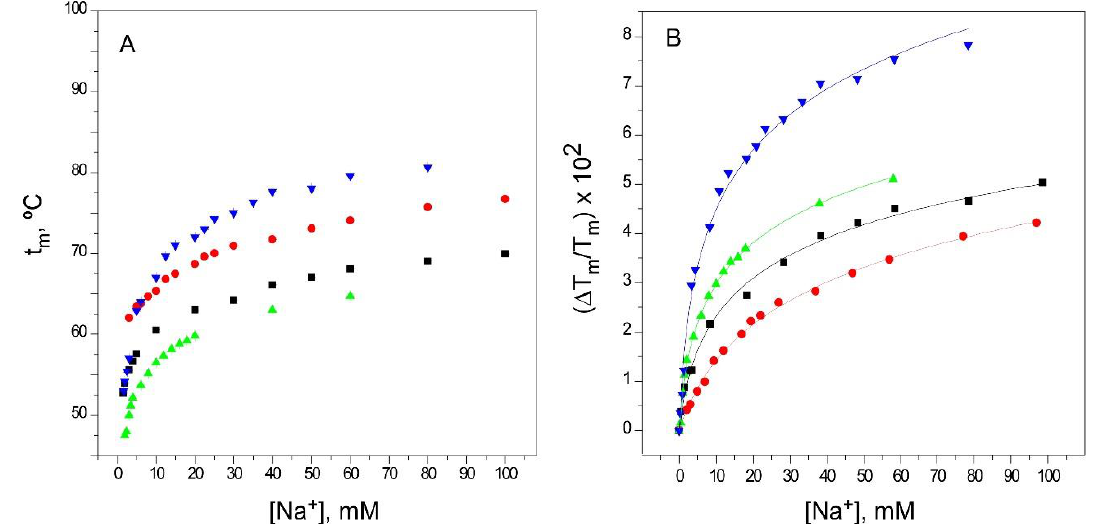
Figure 3 . Binding of Na + to KcsA. Panel A illustrates Na + binding to KcsA channels, monitored through the Na + concentration dependence of the t m of thermal denaturation. The results are the average ( n = 3) t m (in Celsius) ± SD. Symbols and colors are the same as in Figure 2. Panel B shows the fitting of the experimental data from Panel A to Equation (1) (see Methods). The apparent K D values for the above binding events are given in Table 1.